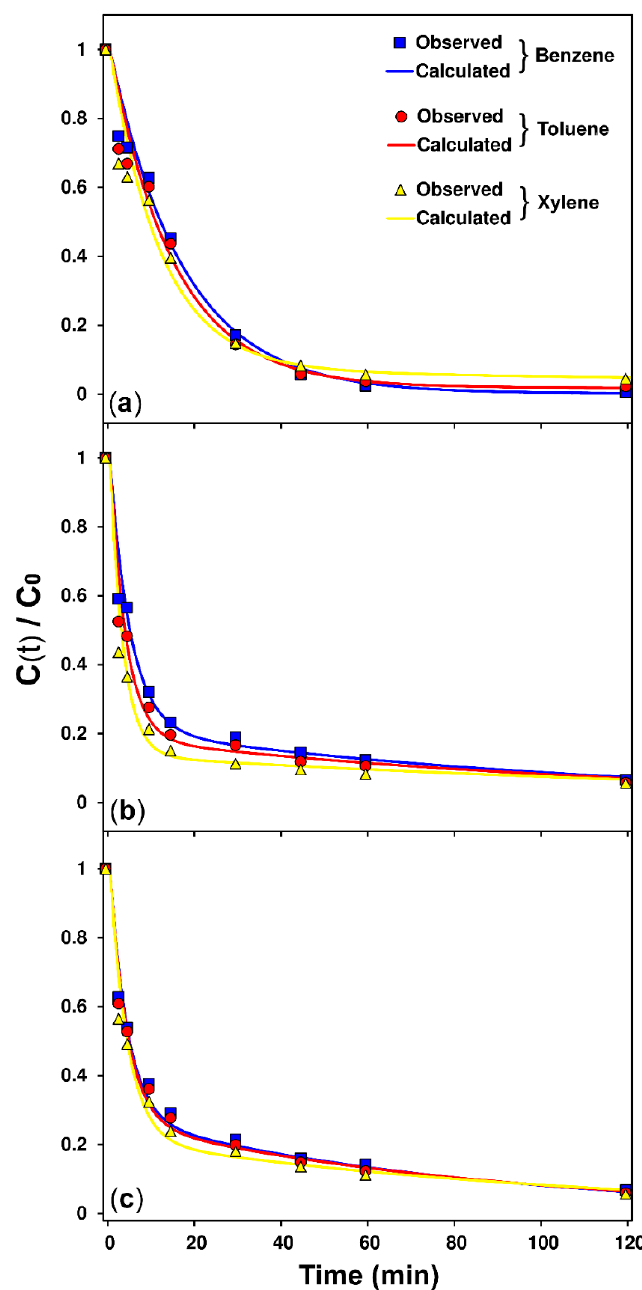
Figure 5. Curve fitting between observed and calculated BTX concentrations for batch tests carried out with: ( a ) raw fibers [RF], ( b ) 4,4 ′ -diphenylmethane diisocyanate functionalized fibers [MDI-FF] and ( c ) plasma functionalized fibers [PFF]. Table 3. Values of the evaporation kinetic constants determined by the evaporation experiment.